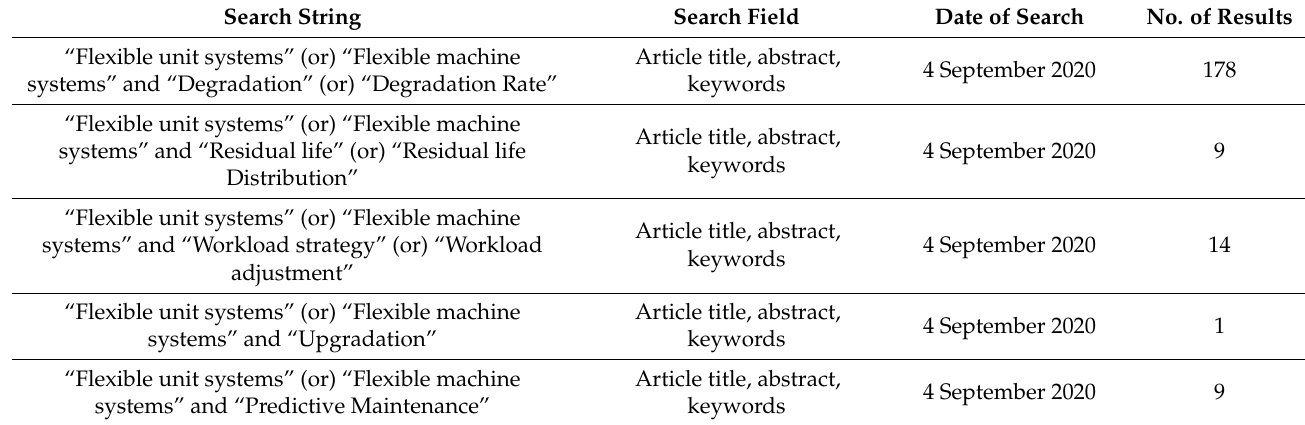
Table 2. Search string and number of results from